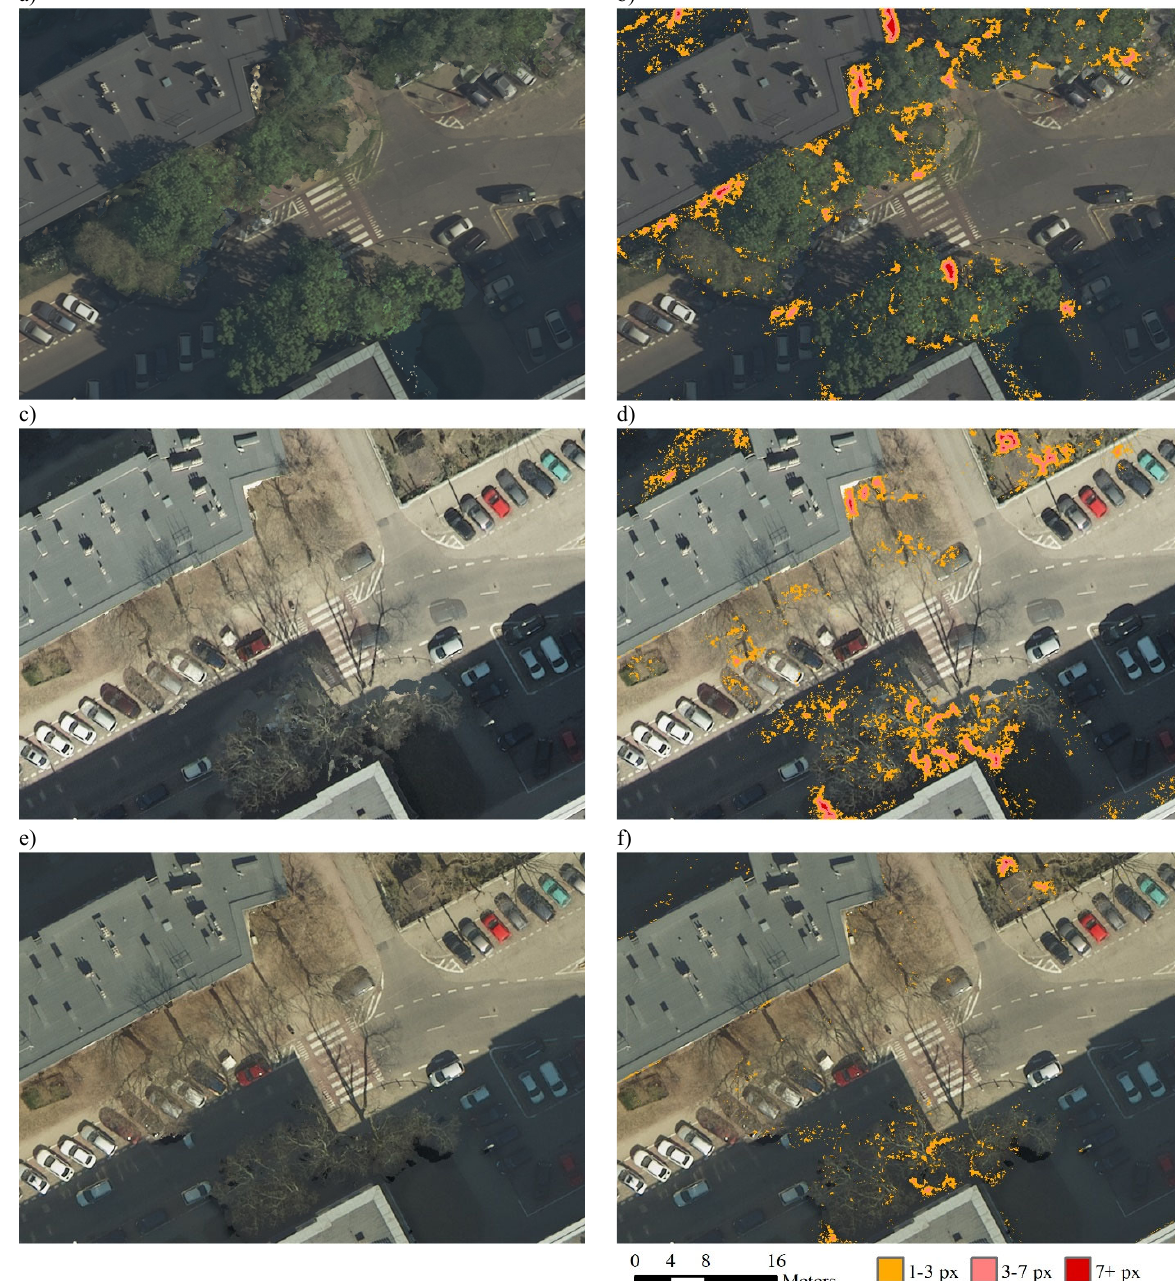
Figure 5. Part of the 1 st test area. True orthophotos (left) and classified interpolation distance (right) from top: datasets (a, b) from 2017 (80/55); datasets (c, d) from 2018 (80/60); datasets (e, f) from 2018